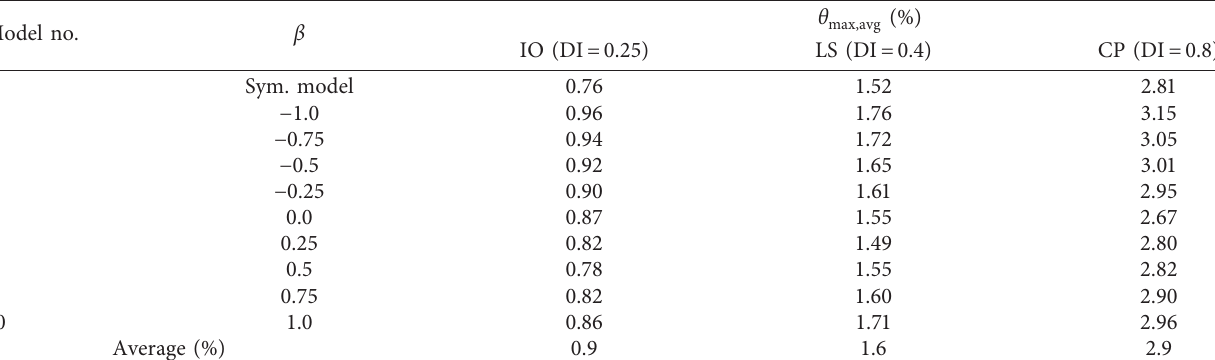
Table 10: The average values of the interstory drift ratios corresponding to DI � 0.25, 0.4, and 0.8 in the models. Model